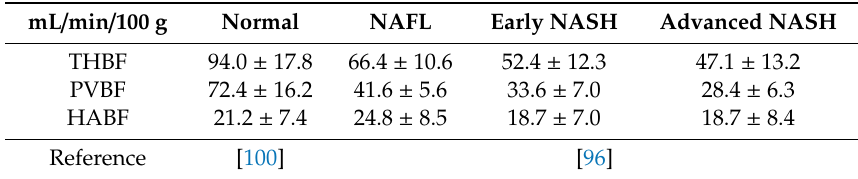
Table 3. Changes in hepatic blood flow in di ff erent stages of nonalcoholic fatty liver disease. Liver blood flow in the disease state was studied using xenon computed tomography. THBF: total hepatic blood flow; PVBF: portal vein blood flow; HABF: hepatic artery blood